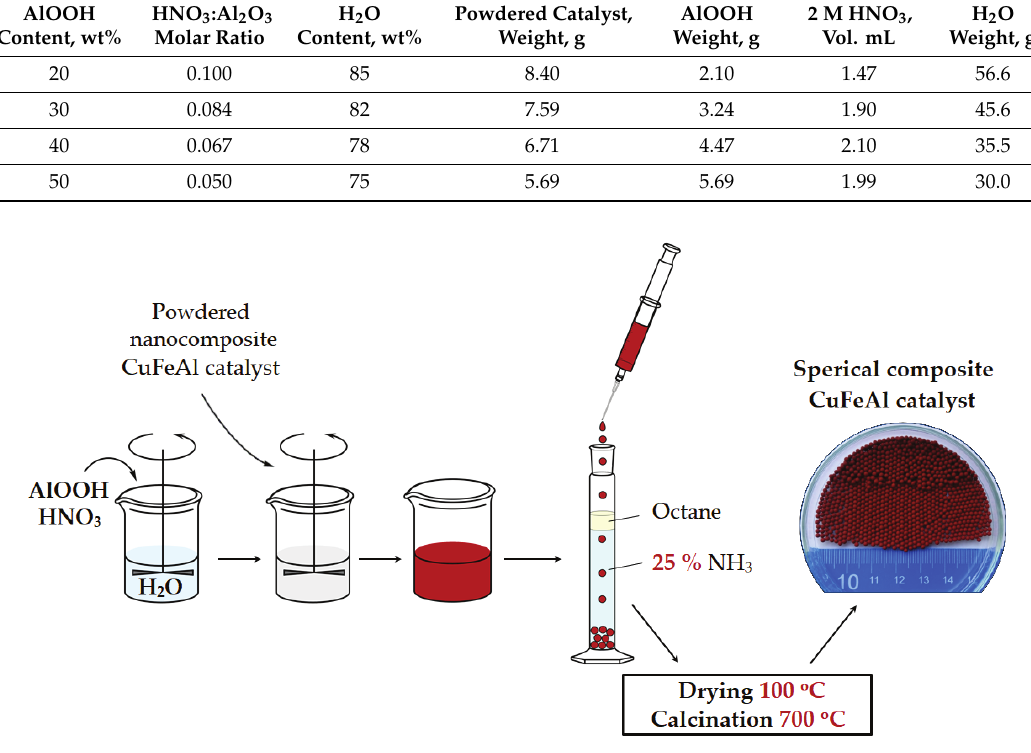
Figure 1. Scheme of the spherical CuFeAl nanocomposite catalyst preparation.